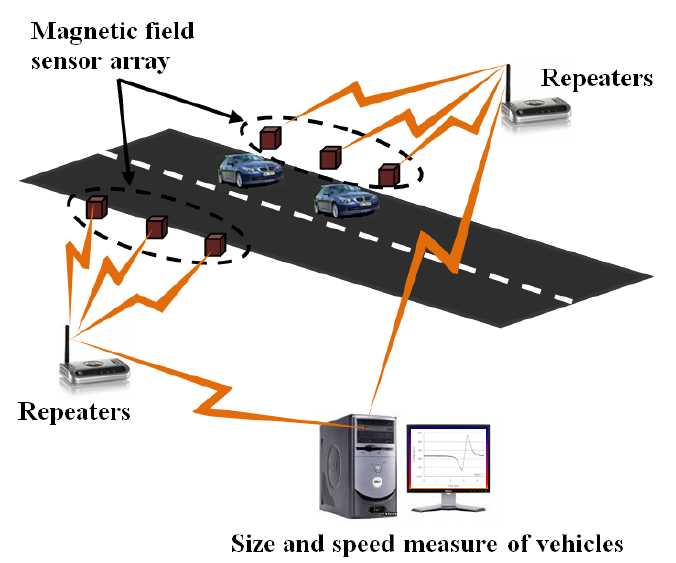
Figure 17. Schematic diagram of the size and speed measure of